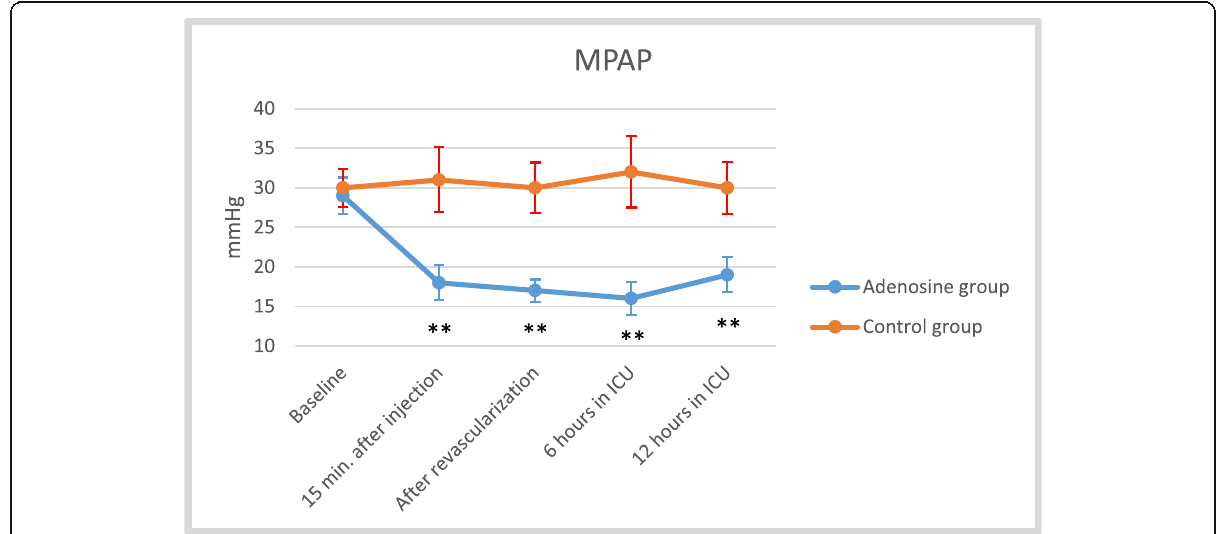
Fig. 3 Effect of adenosine on mean pulmonary artery pressure (MPAP). Data were presented as mean ± SD. ** p value is highly